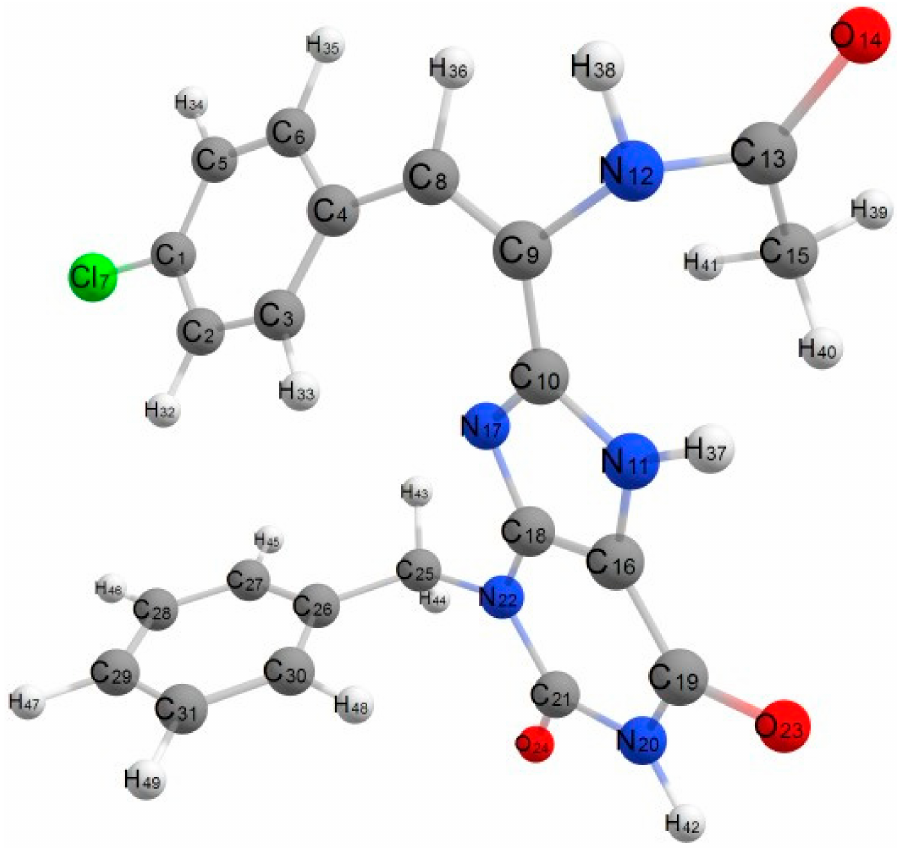
Figure 9. Optimized geometrical structure of compound ( 3 ), N-(1-(3-benzyl-2,6-dioxo-2,3,6,7 - tetrahydro-1 H -purin-8-yl)-2-(4-chlorophenyl)vinyl)acetamide by using DFT calculations.